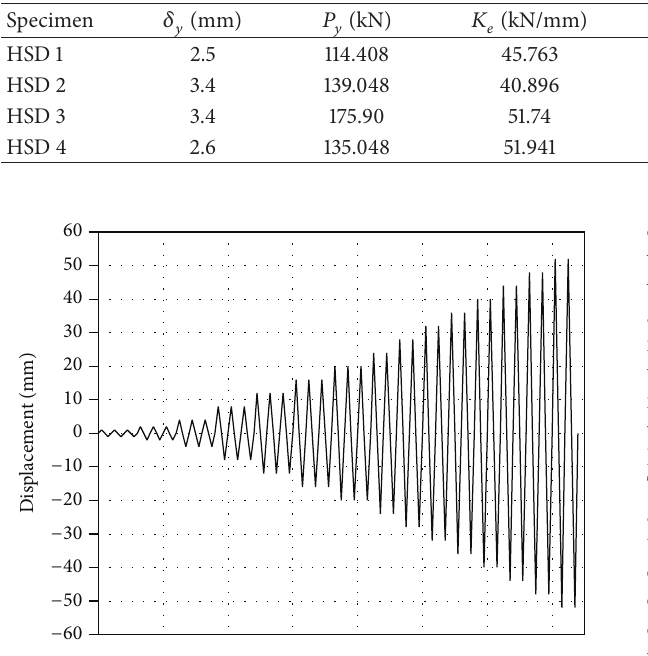
Table 2: Summary of test results.